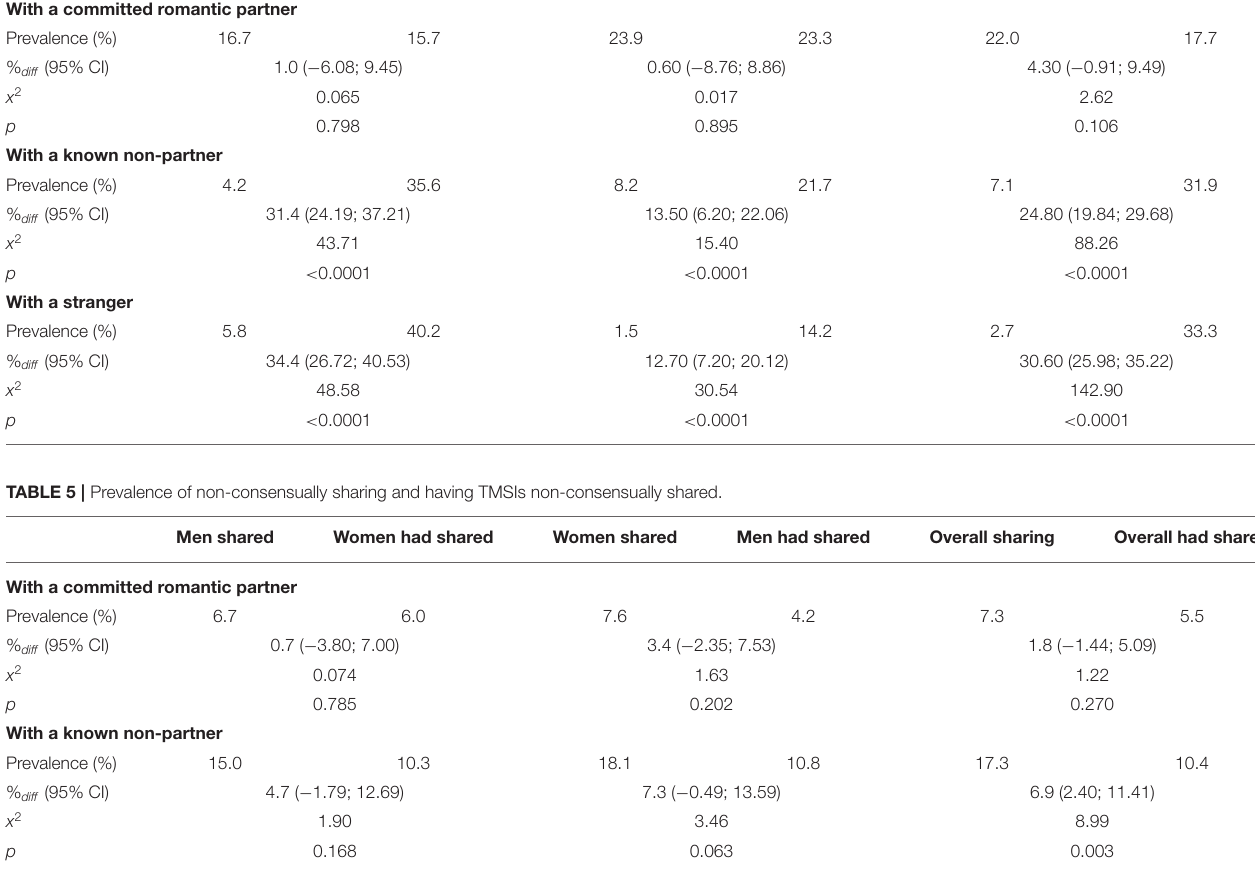
TABLE 4 | Prevalence of sending and receiving non-consensual TMSIs. Men sending Women receiving Women sending Men receiving Overall sending Overall receiving With a committed romantic partner